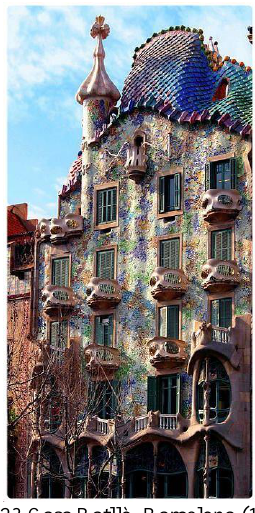
Fig. 23 Casa Batllò, Barcelona (1906)